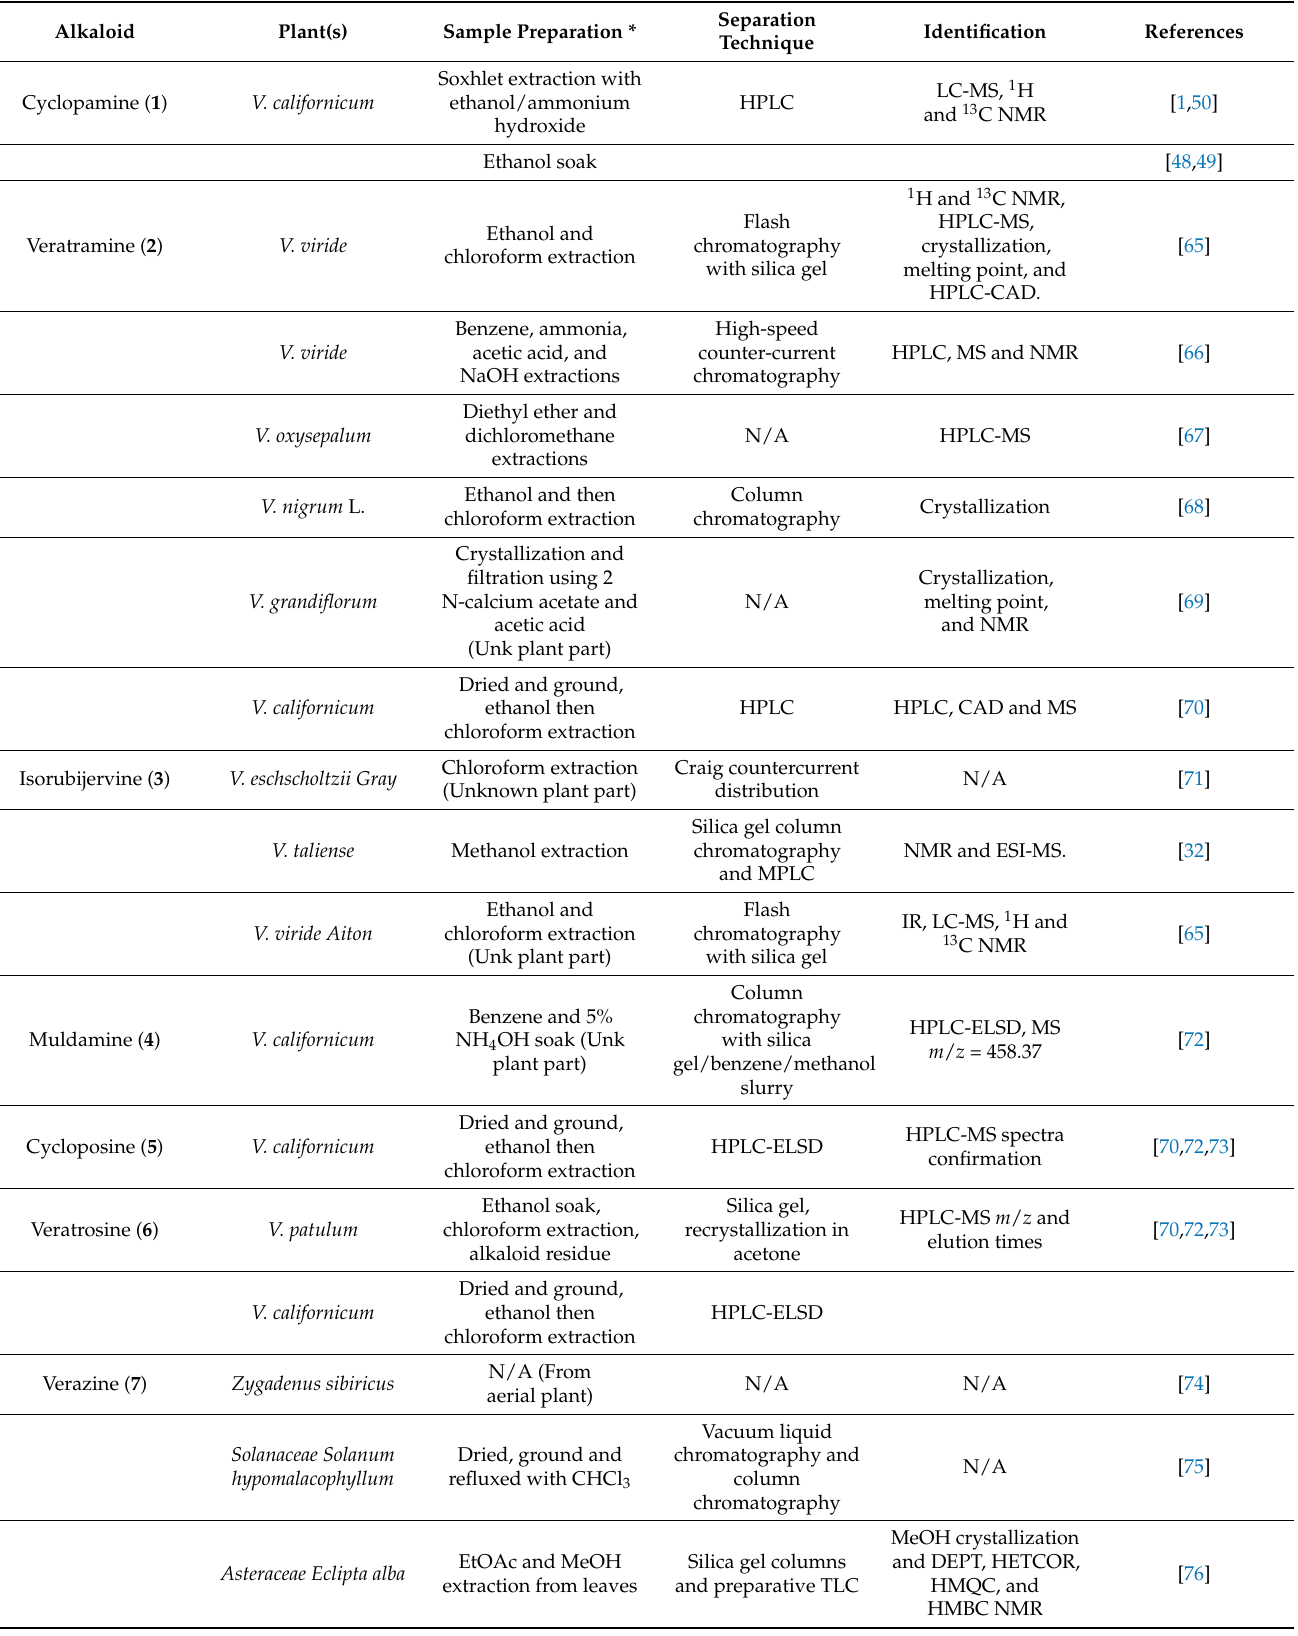
Table 3. Methods of extraction, separation, and identification of Veratrum